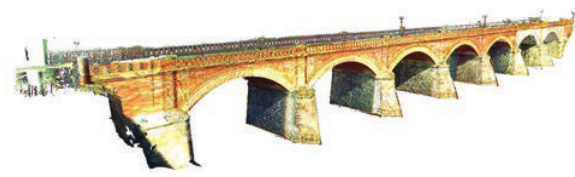
Fig. 4. 3D model of the bridge generated from the Laser scanned data